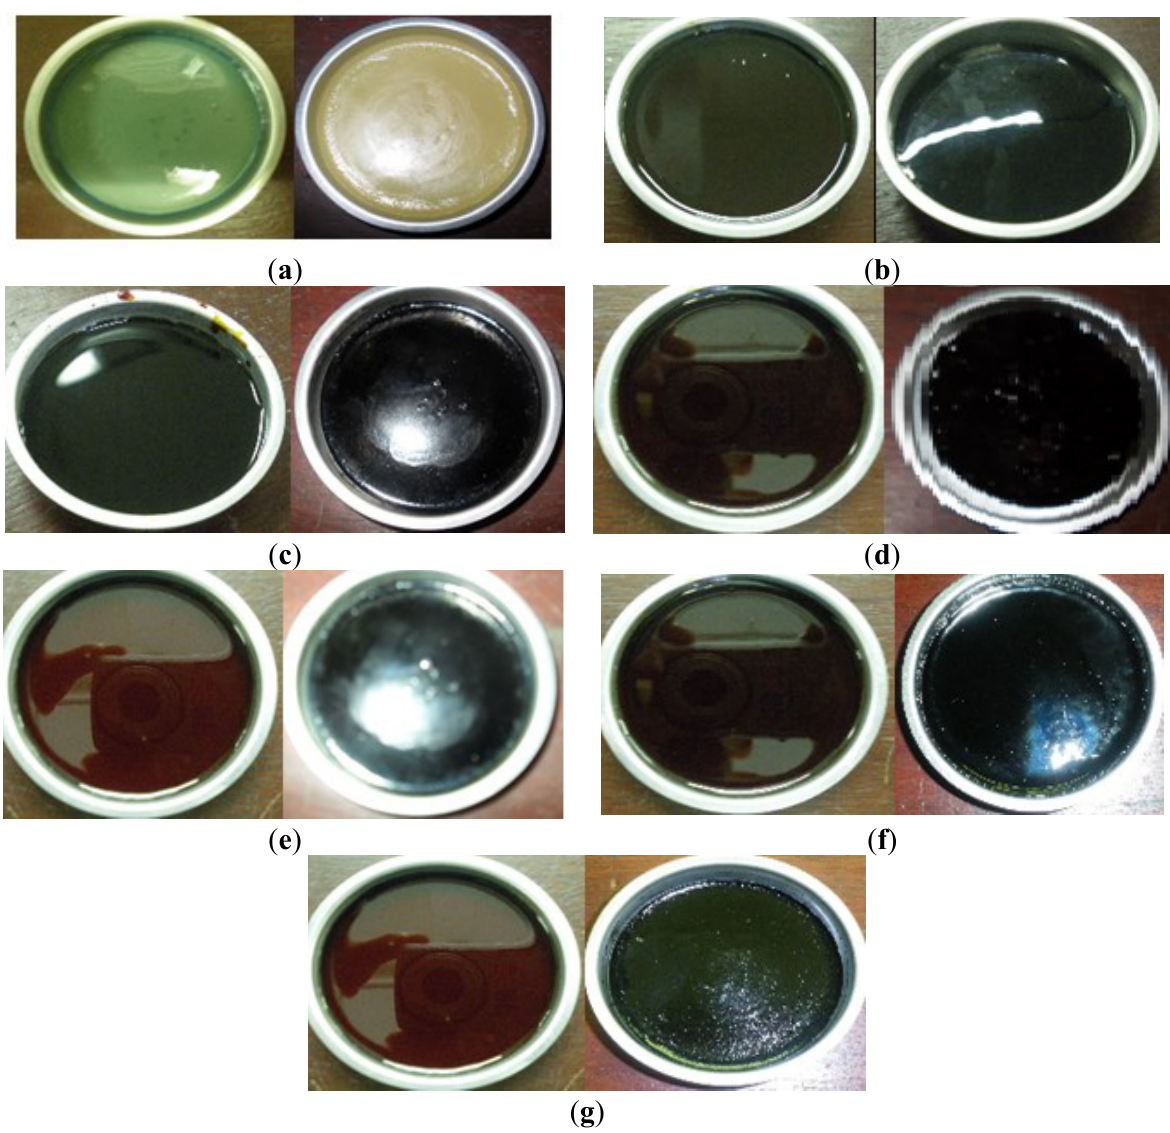
Figure 1. Digital images of uncured and cured samples of ( a ) UP; ( b ) FL; ( c ) FB; ( d ) 50/50 UP/FL; ( e ) 70/30 UP/FL; ( f ) 50/50 UP/FB and ( g ) 70/30